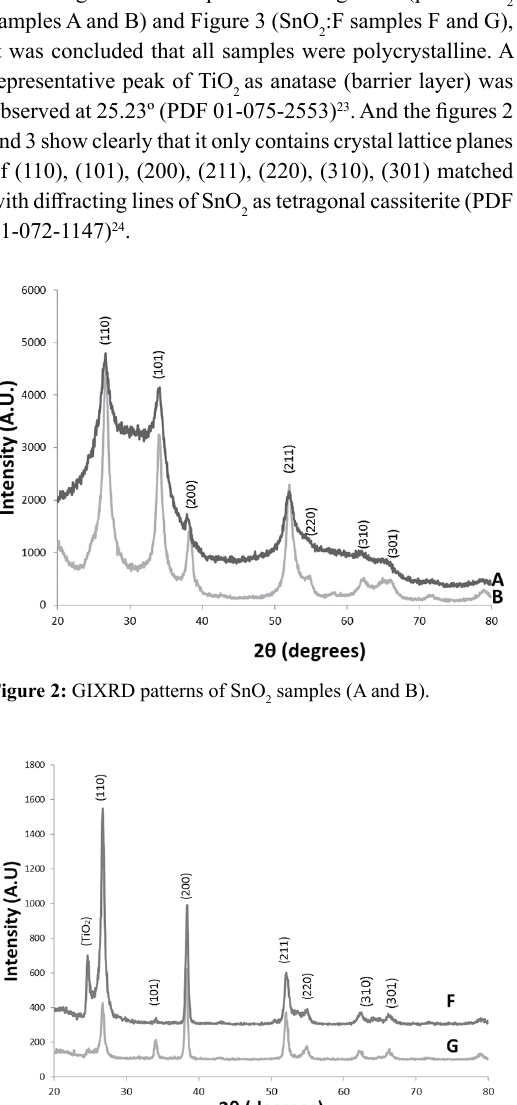
Figure 3: GIXRD patterns of doped samples with fluorine. (Samples F and G). These samples presented only single-phase cassiterite structure.